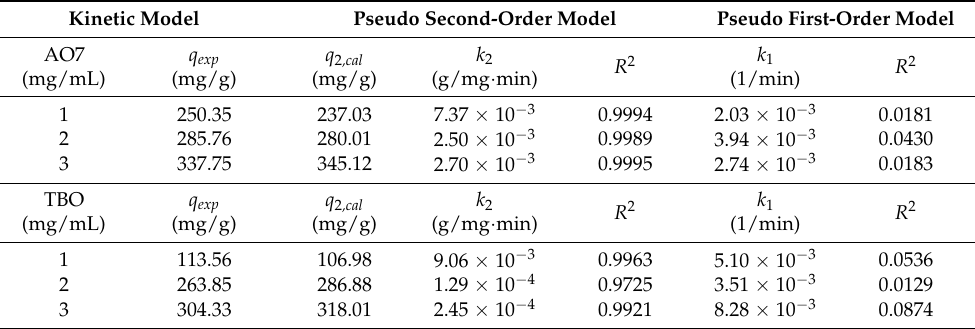
Table 2. Pseudo first-order and pseudo second-order kinetic rate constants, calculated and experiment q values for the adsorption of AO7 and TBO dyes onto the P-COOH-CS-CEW nanofiber membrane at different dye